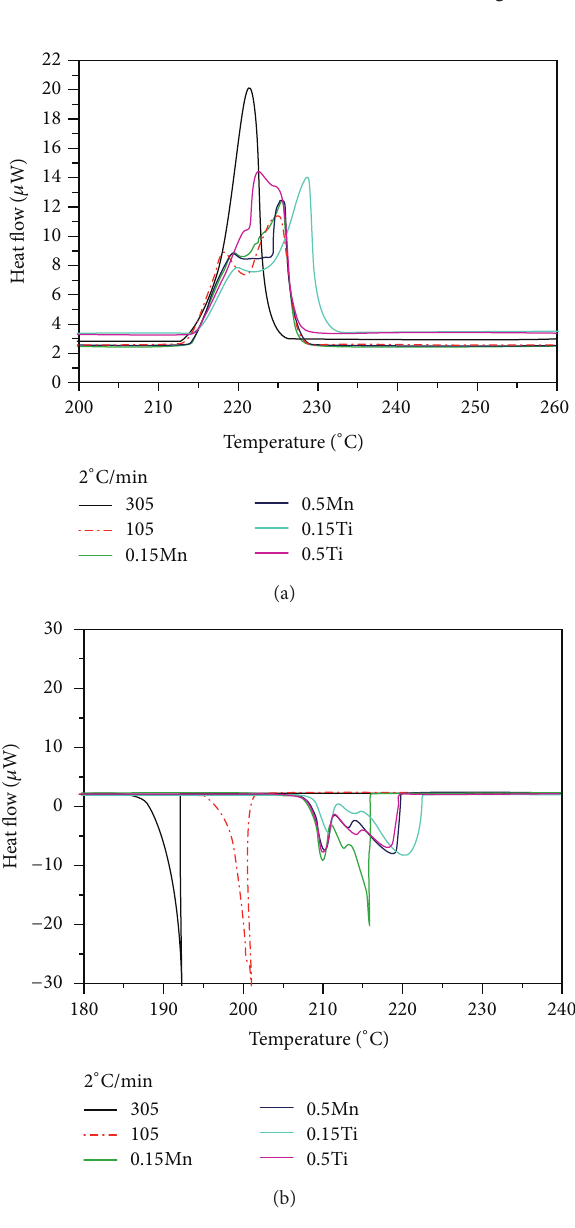
Figure 1: DSC curves of the samples: (a) upon heating and (b) upon cooling